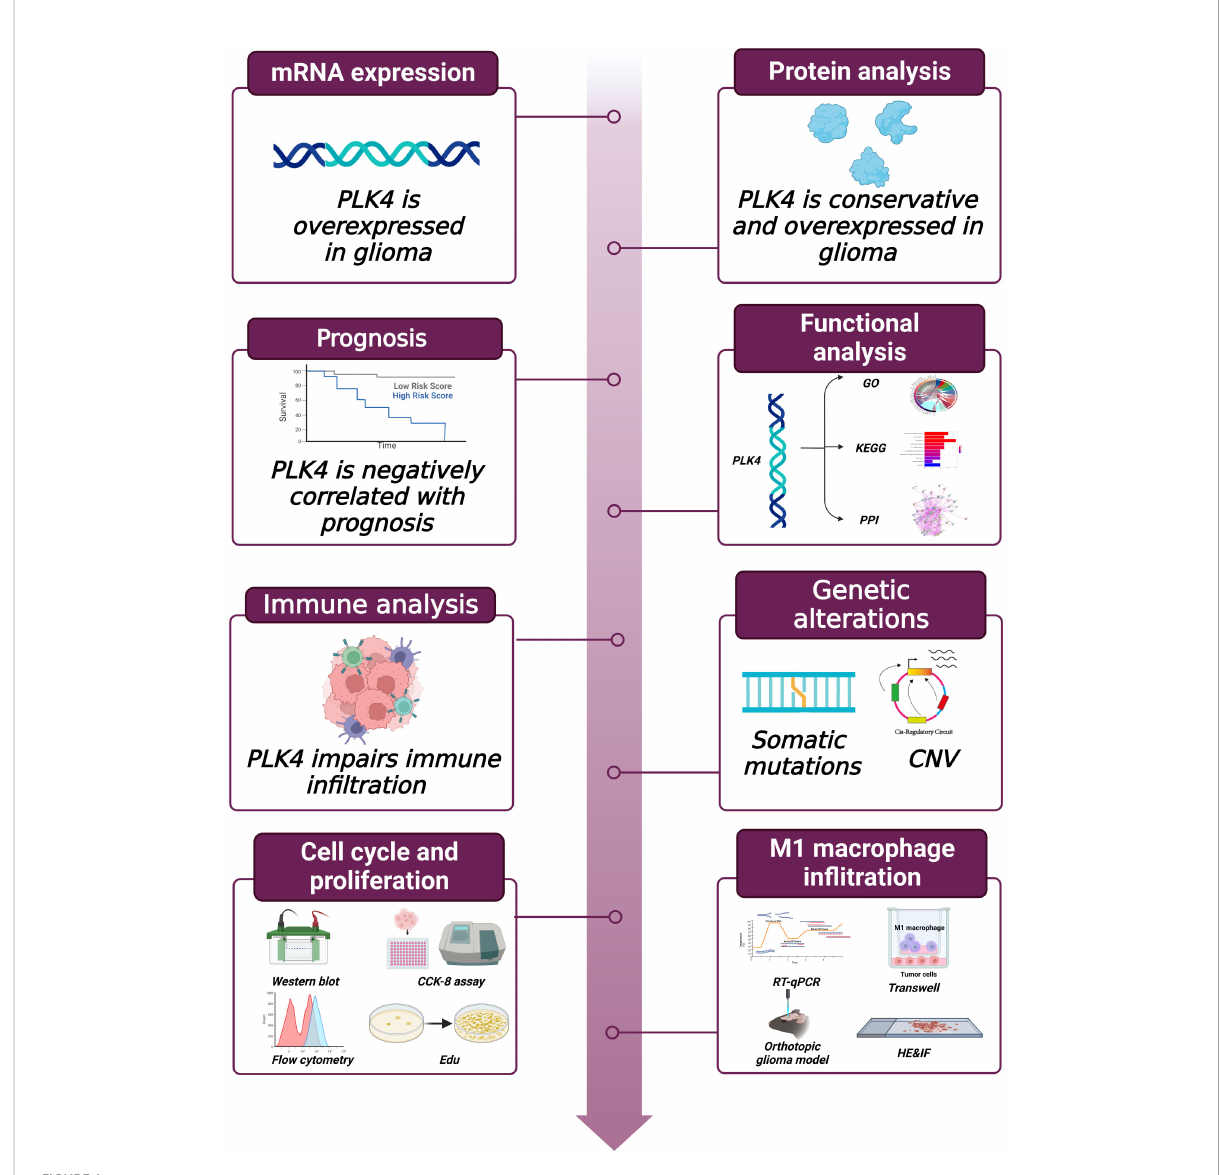
FIGURE 1 Work fl ow of this